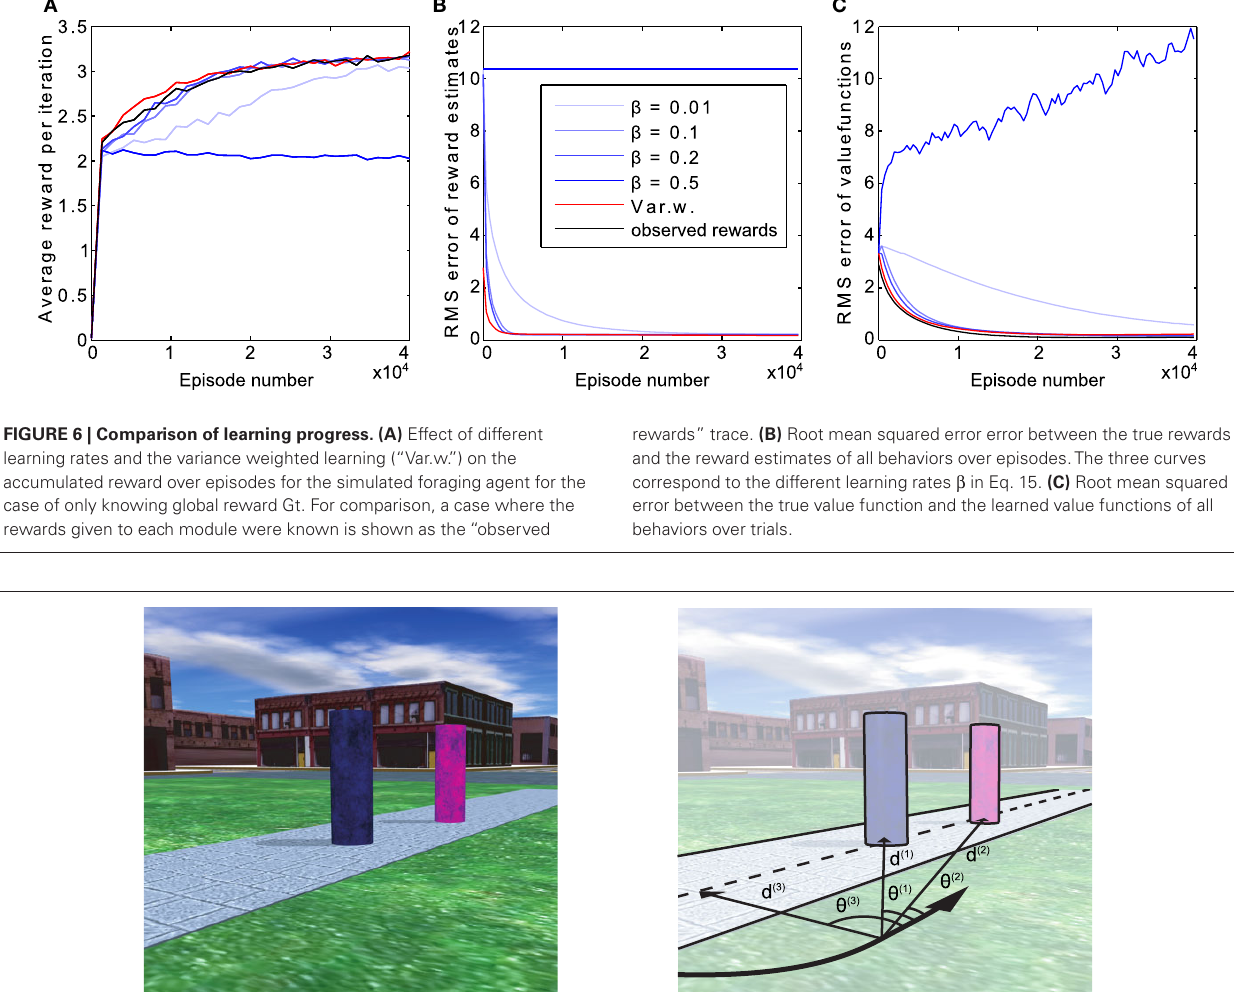
distance to the closest object in the field of view and the angle between the current heading direction and the object center axis. The module learning the walkway behavior uses the signed distance to the midline of the walkway and the angle between the heading direction and the vector in the direction of the walkway.